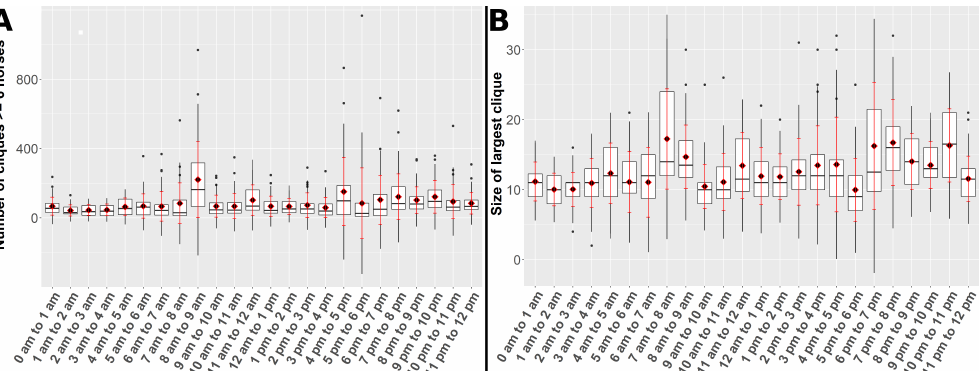
Figure 5. The underlying hourly contact networks were obtained between the 2nd of June and the 3rd of July 2018. The red diamonds mark the means and the red bars represent the mean ± standard deviation. ( A ) Boxplot displaying the numbers of cliques with more than six horses. ( B ) Boxplot displaying the sizes of largest cliques.